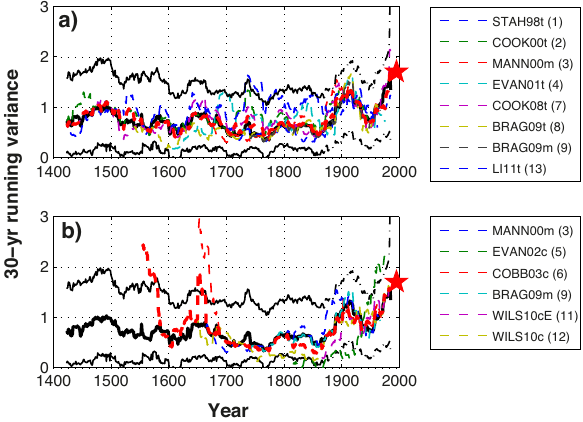
Figure 8: a) the running variance of each of the 8 ENSO reconstructions with common tree ring source proxies (Proxy names and numbers correspond to those in Table 1), overlaid with the corresponding MRV (thick dashed red line). b) the running variance of each of the 6 ENSO reconstructions with common tropical coral reconstructions (Proxy numbers in legend correspond to those in Table 1), overlaid with the corresponding MRV (thick dashed red line). The underlying thick black line in both panels represents the MRV of all 14 ENSO reconstructions presented in Fig. 7 and Table 1, while the thin black lines represent the accompanying ENSO reconstruction MRV signal error bars (Appendix A). The red star indicates the most recent value of the observed MRV (See figure 7).